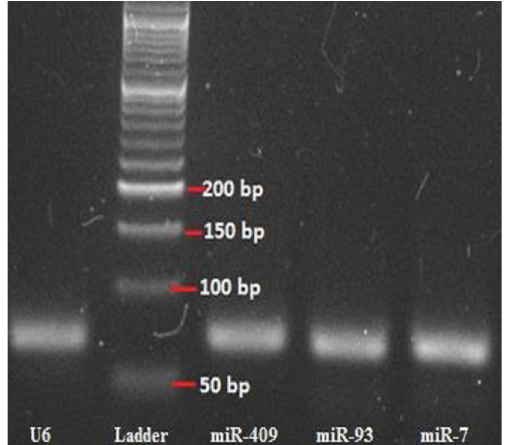
Fig. 1. Assessment of PCR products on agarose gel: From right to left, the specific products of miRNA- 7, miRNA-93, miRNA-409, and U6 were shown on an agarose gel.